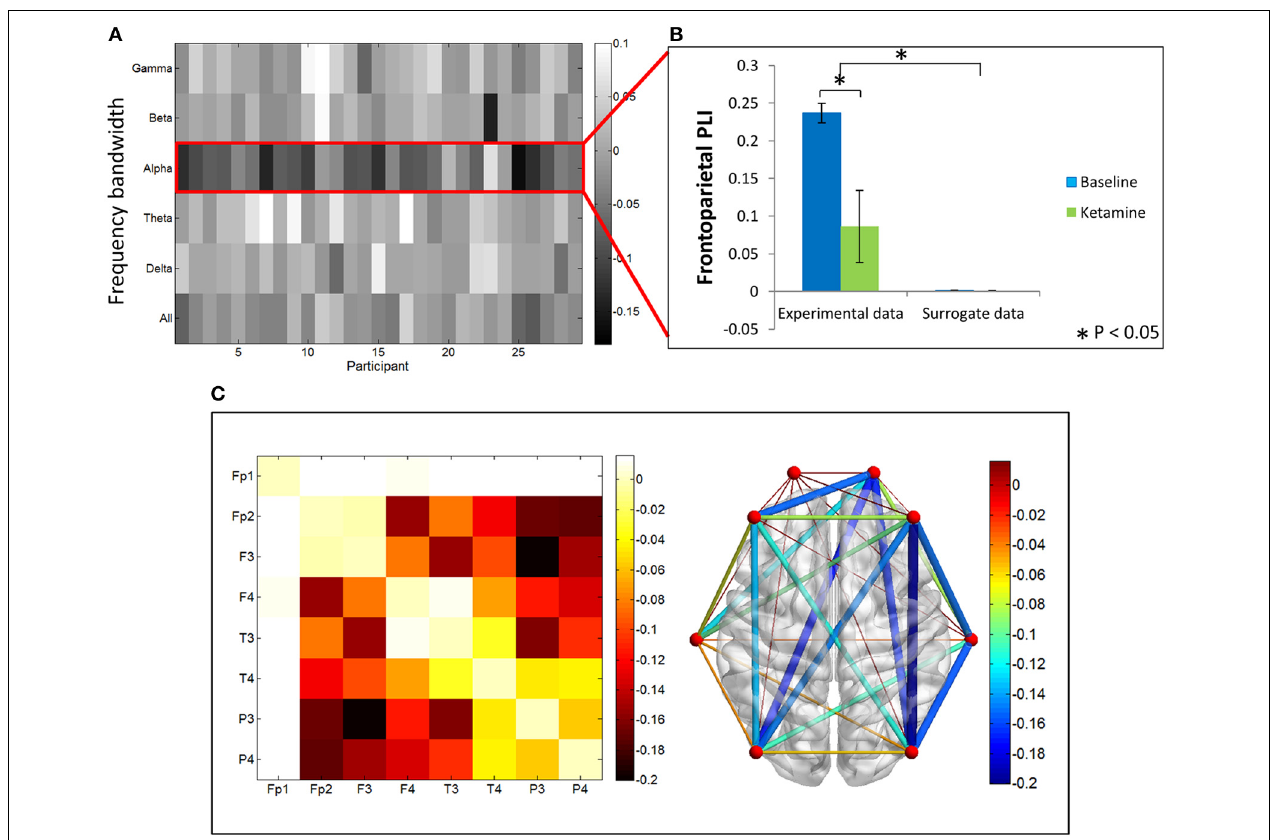
phase-locking is observed in the surrogate dataset. (C) Average difference in PLI between baseline and unconscious states across all channel combinations, represented on a channel grid (left), and on the axial view of the brain (right). Color and size of edges in the brain network represent the difference in PLI between baseline and unconscious states. Large decreases in PLI are observed between frontoparietal channel